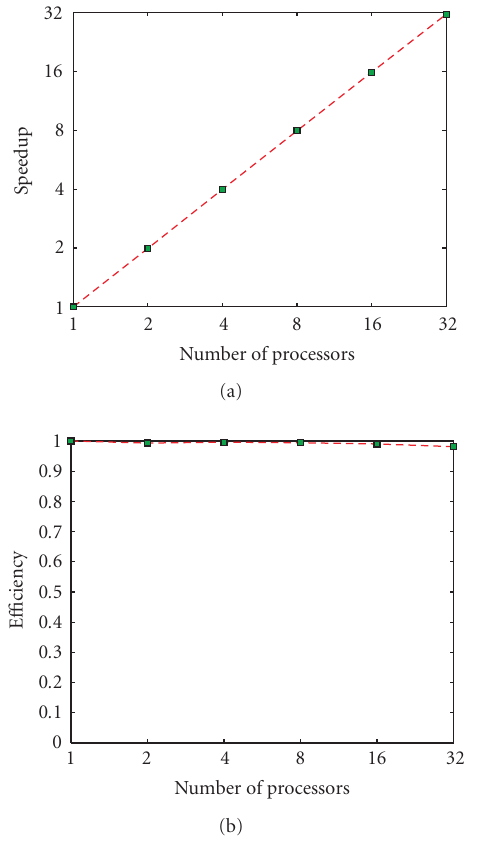
Figure 11: The illustration of the algorithm’s speedup and e ffi - ciency with the image volume 512 × 512 ×